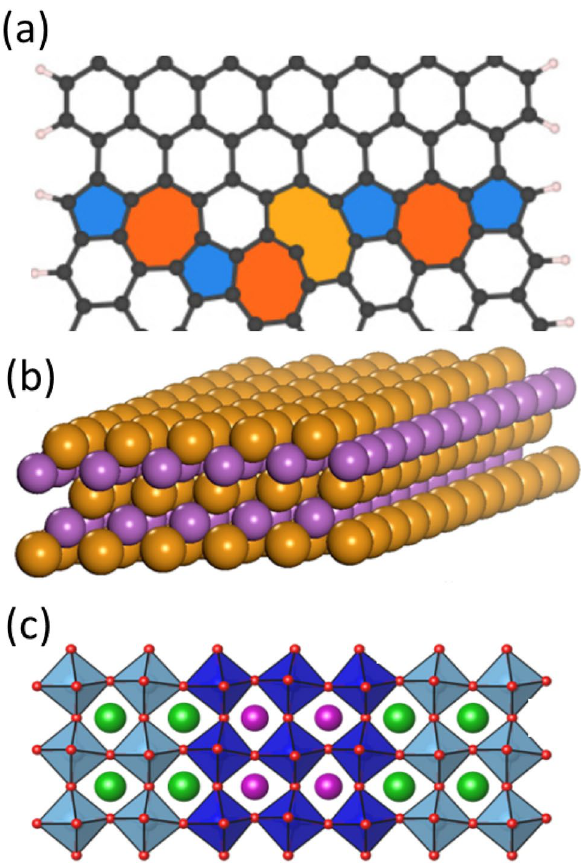
Fig. 10 Schematic representation of grain boundaries in a polycrys- talline materials and b multilayered heterostructures. Variations in colors represent different crystallographic orientations in grains or different material compositions in solid solutions or heterostructures. Grain boundaries are denoted with black lines